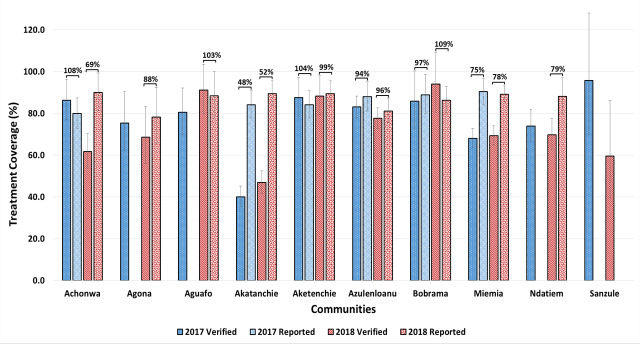
Verification of MDA coverage rates for 2017 and 2018.Error bars represent the 95% Confidence Intervals. The 2017 reported coverage for Agona, Aguafo and Sanzule, as well as the 2018 reported coverage for Sanzule were not found in the district databases. The values above the brackets indicate the verification factors between the verified and reported coverages, for the different years for each community. Values between 95 and 105 indicate high quality reporting, while values below 90 and above 110 are indicative of poor-quality reporting. Values <90 indicate over reporting and values >110 indicate under reporting. Achonwa, Agona, Aguafo and Ndatiem belong to the Nzema east District. Akatanchie, Aketenchie and Miemia belong to the Ahanta West District. Azulenloanu, Bobrama, and Sanzule are in the Ellembele District.